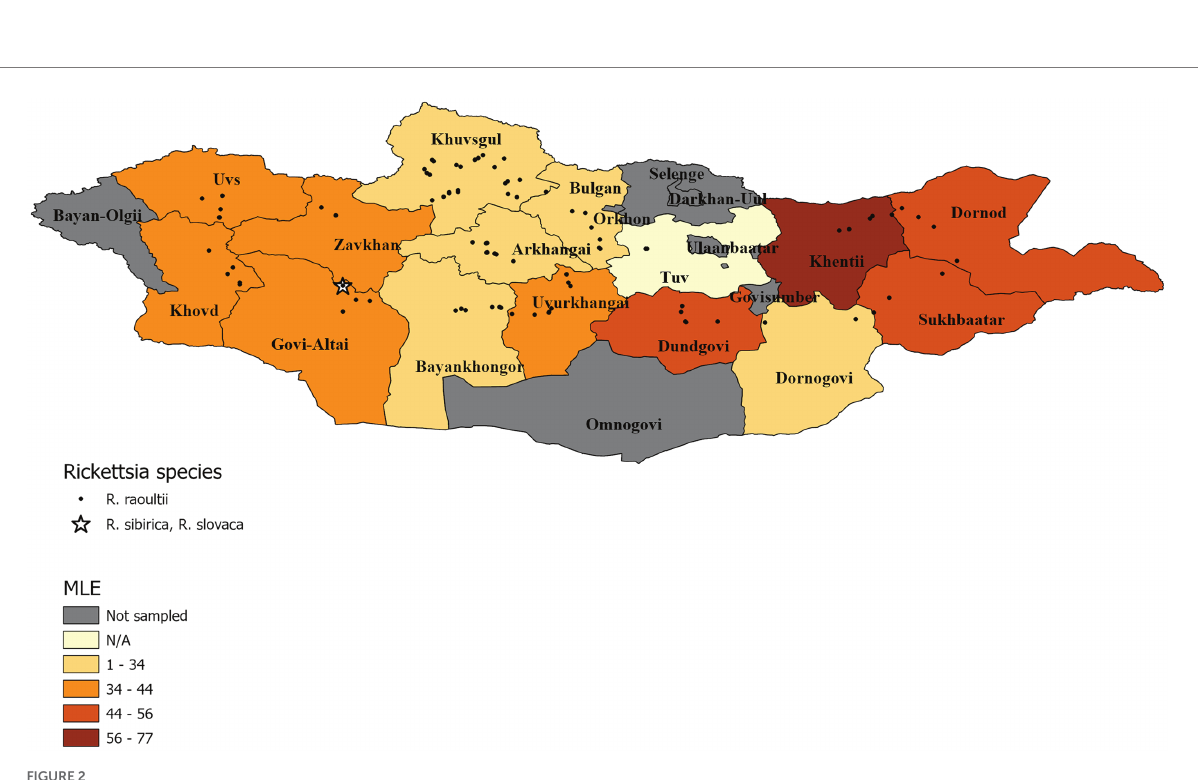
FIGURE 2 Pool MLE for Rickettsia spp. A map showing the distribution of identified Rickettsia species, with an aimag color gradient representing the Rickettsia spp. MLE of sampled pools within the aimag. MLE calculation for Tuv is N/A because detection rate was